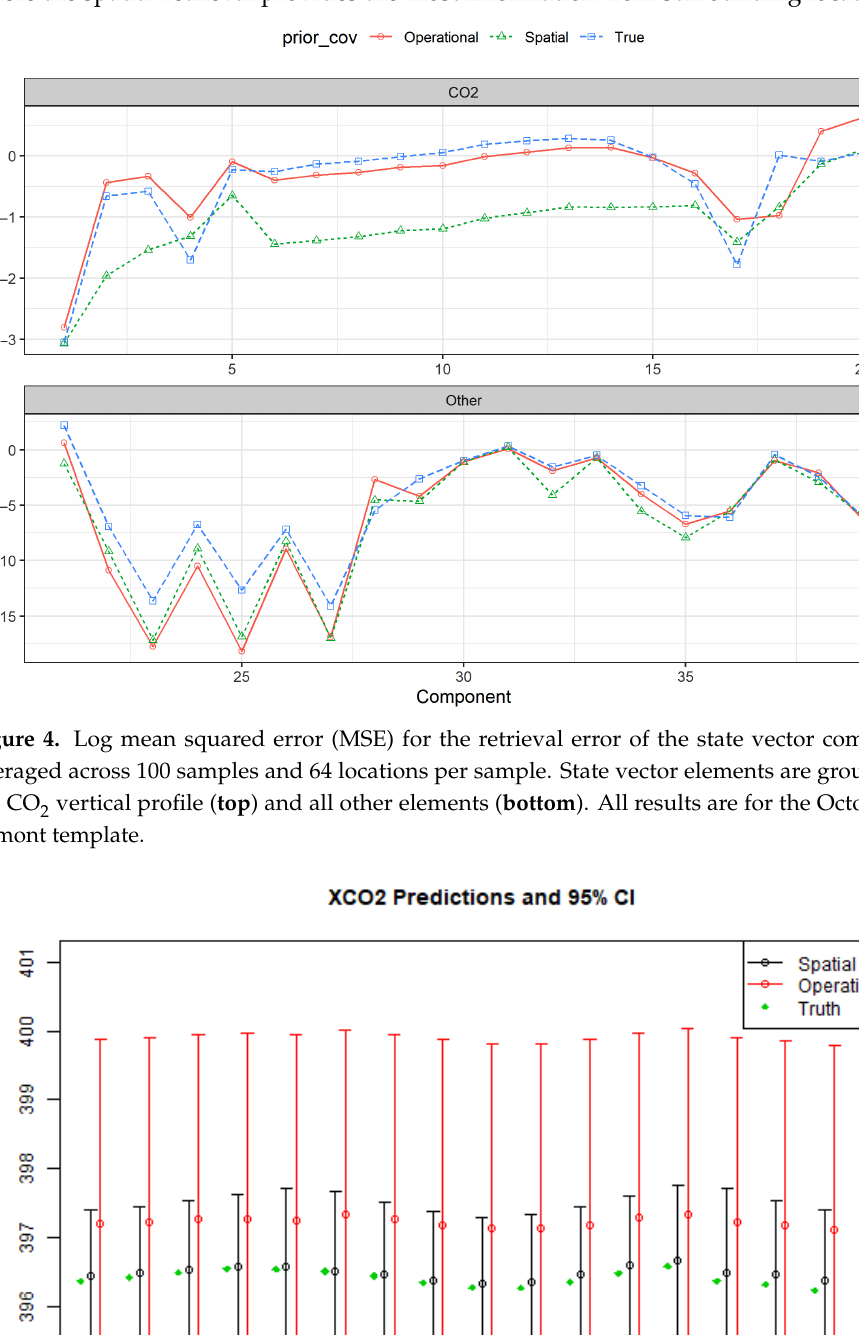
(in ppm) at a subset of the 2 2